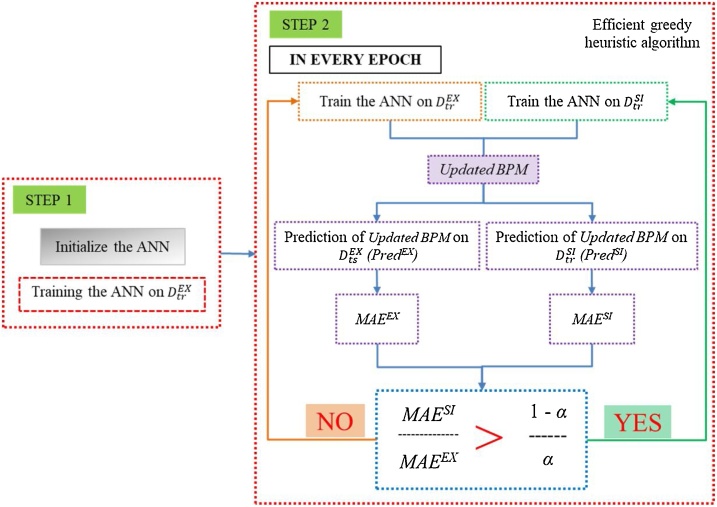
Training algorithm.